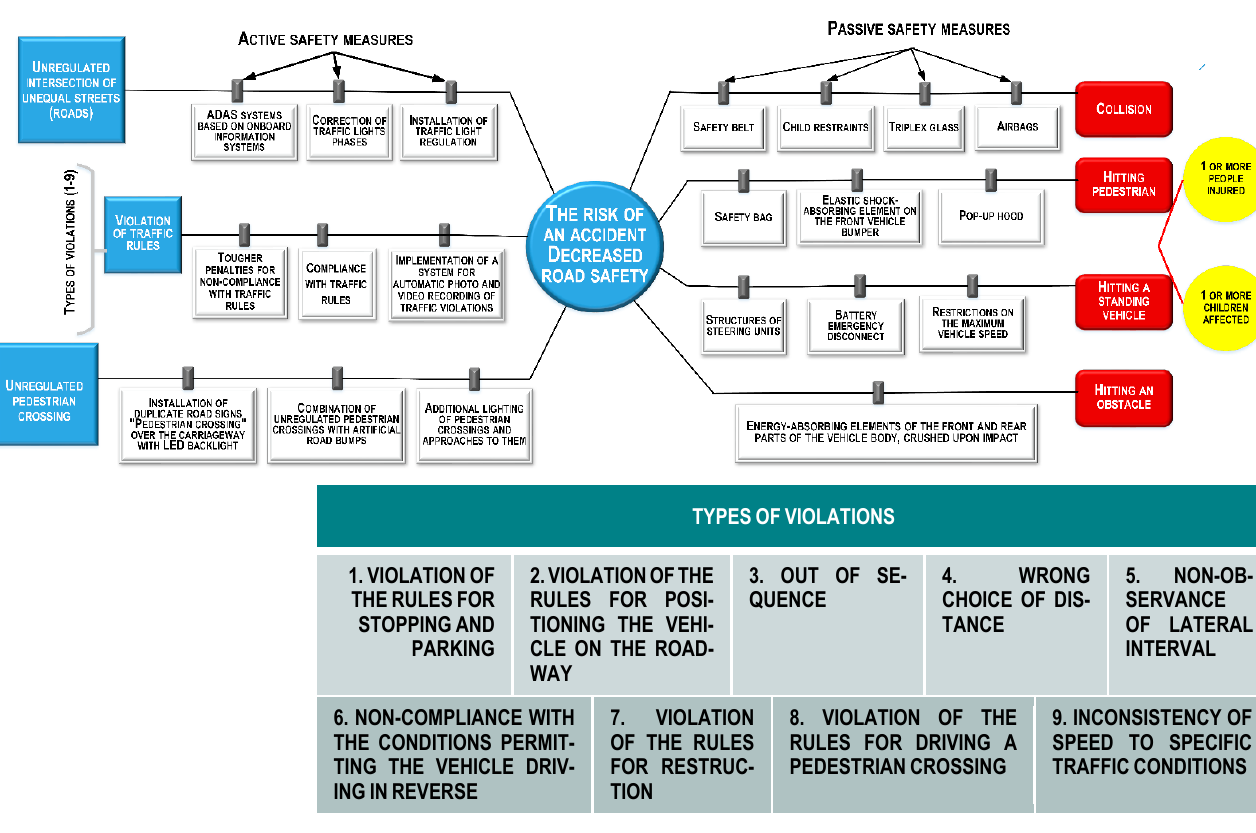
Figure 4. Bow-tie diagram.